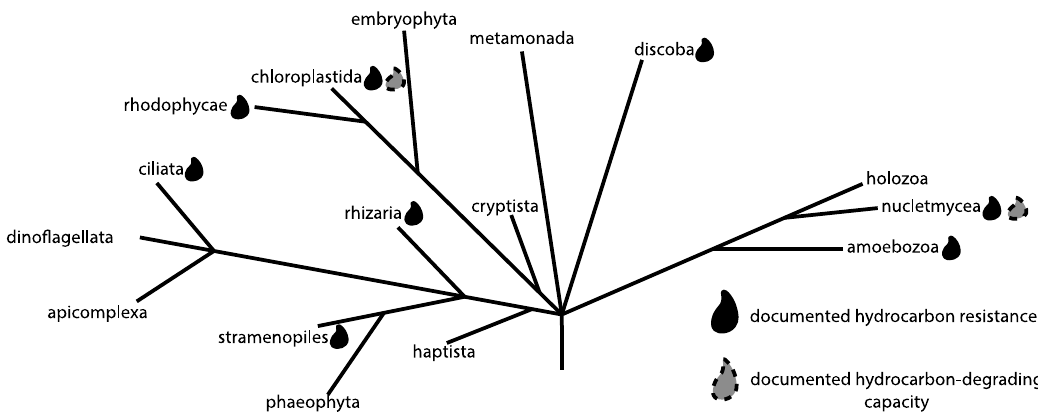
Figure 1. Diversity of eukaryotes, based upon Adl et al. [1]. Groups with noted resistance to hydrocarbons, or ability to degrade hydrocarbons, are indicated. It is important to note that not all taxa within the indicated groups exhibit these traits, as the tree covers all eukaryotic diversity and is therefore at extremely low taxonomic resolution. The well-known multicellular eukaryotes, i.e., animals, plants, and fungi are found within the Holozoa, Chloroplastida, and Nucletmycea respectively. These same groups also contain large numbers of microbial taxa.